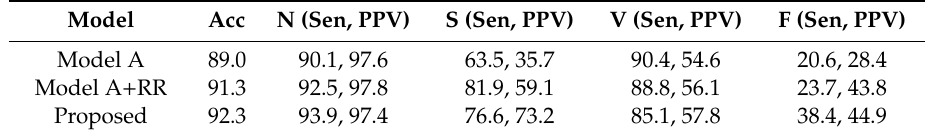
Table 7. The results on the proposed method compared with the single-scale method. RR: six time features.